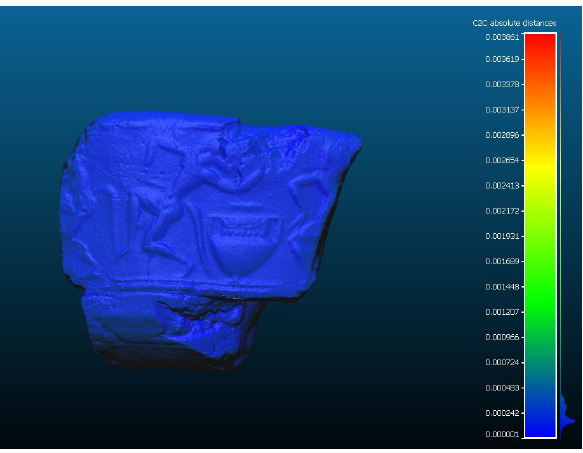
Figure 12. Cloud-to- cloud distance between dense point clouds of the fragment with Komòs